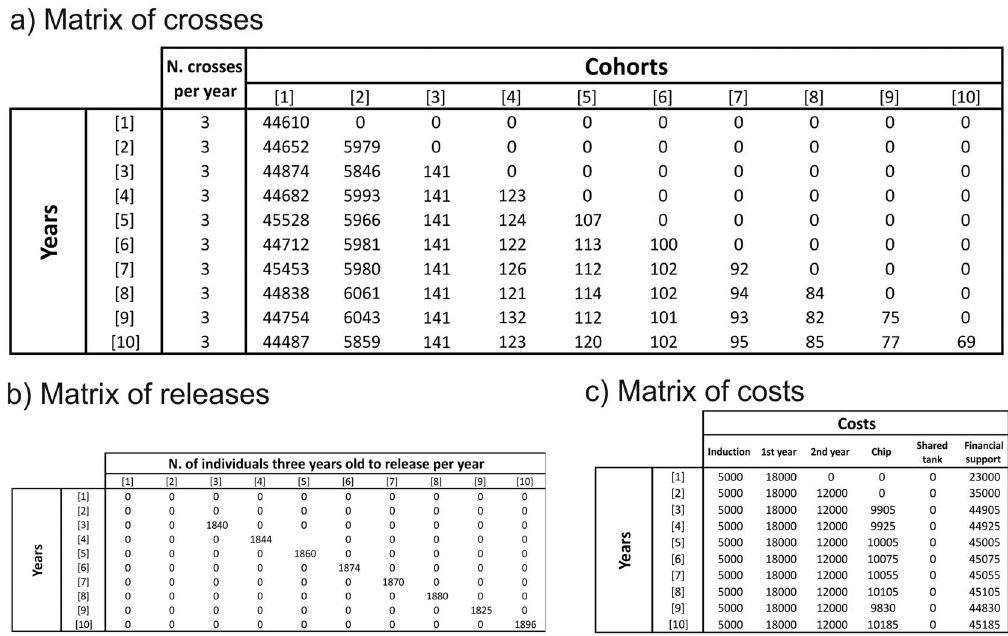
Figure 3. Example of output of the R-script ‘‘ CostsBreedingSturgeons ’’. The run was performed using six tanks available for the first two years of rearing and one common pond of 1200 mq for the following years. (a) Number of individuals for each cohort (columns) maintained in captivity in